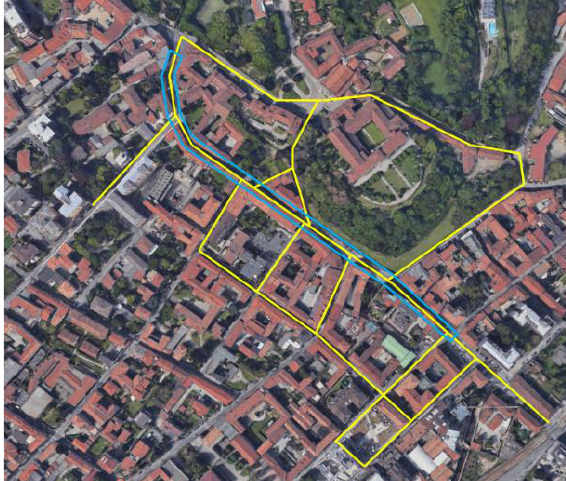
Figure 1. Area interested by the survey in the centre of Meda (MB). Corso Matteotti is highlighted in blue. Trajectories covered by the IMMS are yellow-coloured.